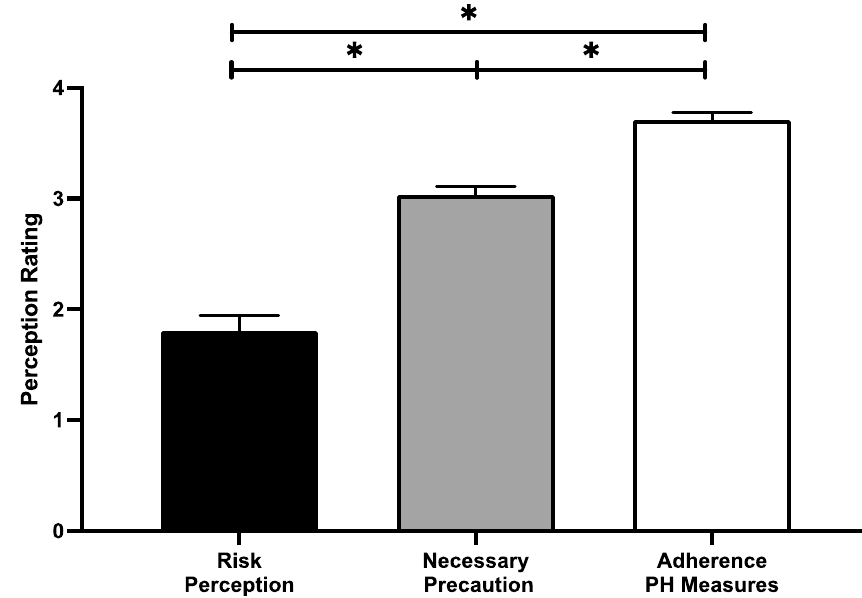
Figure 1. Self-reported rating on a 4-factor scale (where 4 indicates the greatest importance) for COVID- 19 risk perception (black), perceived necessity for public health measures to mitigate COVID-19 (grey), and perception of an individual’s adherence to public health (PH) measures